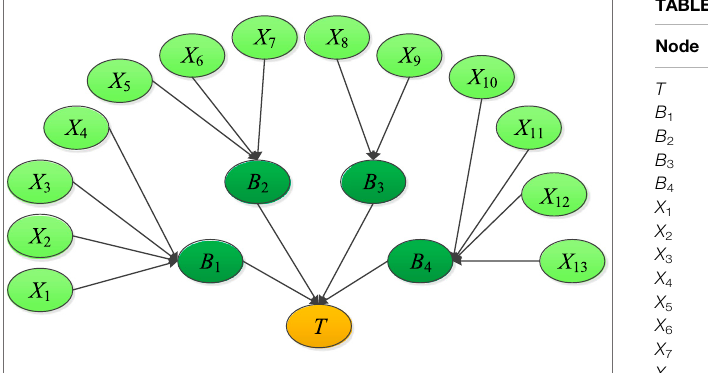
FIGURE 4 | Established network model for the tunnel collapse MCBN.